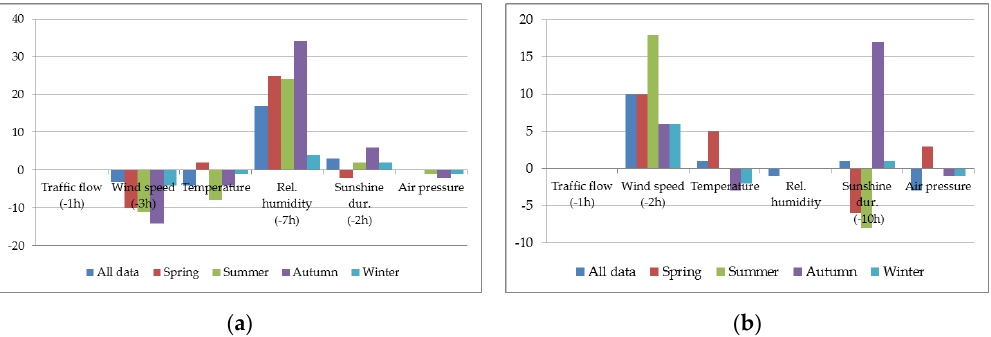
Figure 2. Differences between feature importance ( y -axis) for Lag and Current models for ( a ) NO 2 and ( b ) NO x prediction.